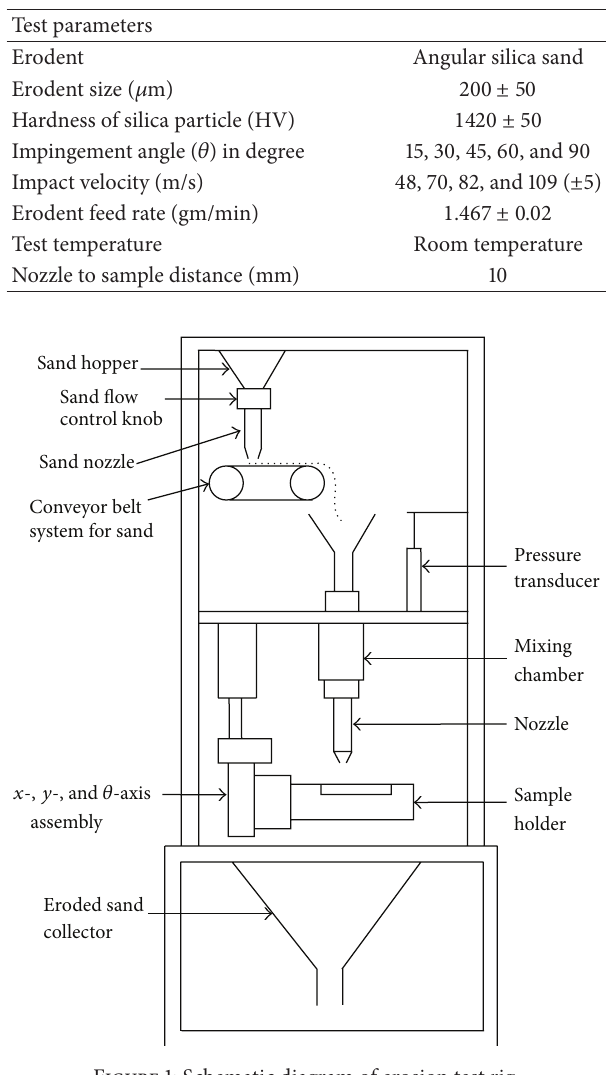
Table 1: Erosion test conditions.